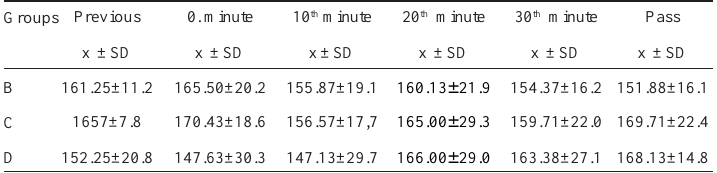
Table 1. Heart rates (beats per minute)